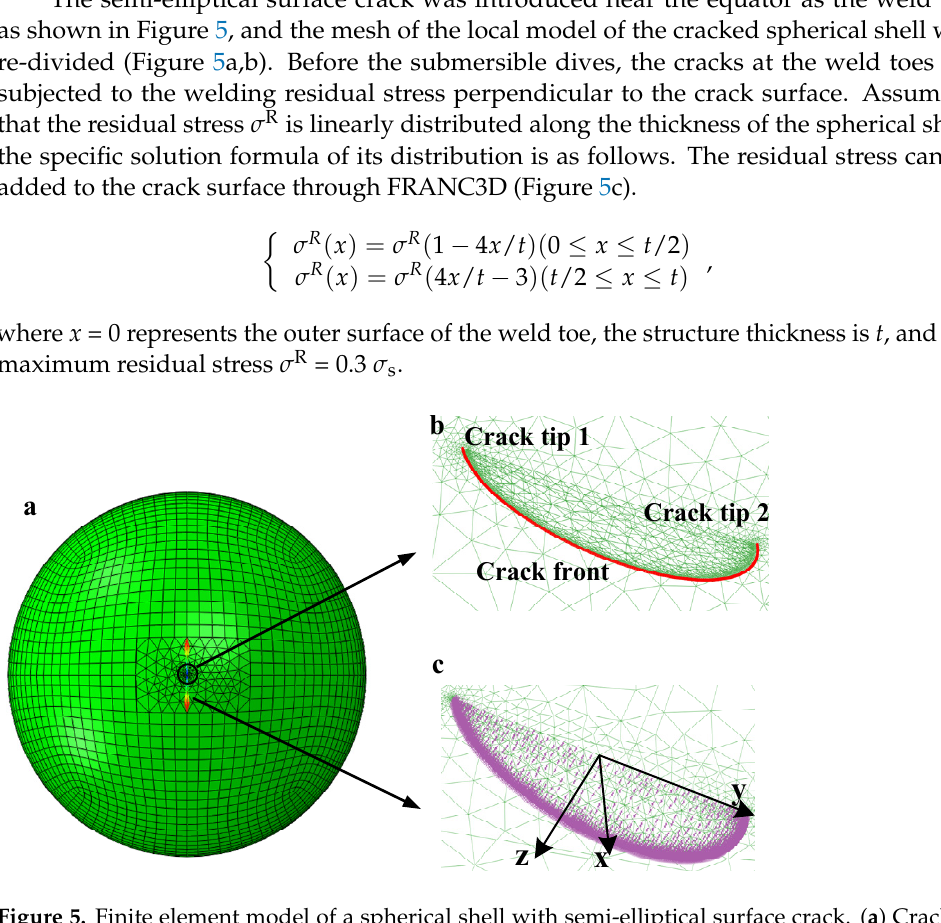
Figure 5. Finite element model of a spherical shell with semi-elliptical surface crack. ( a ) Cracked spherical shell model; ( b ) Semi-elliptical surface crack; ( c ) Distribution of welding residual stress.